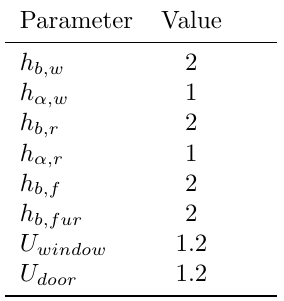
Table 2: Heat transfer coefficients [W/( m 2 K)]